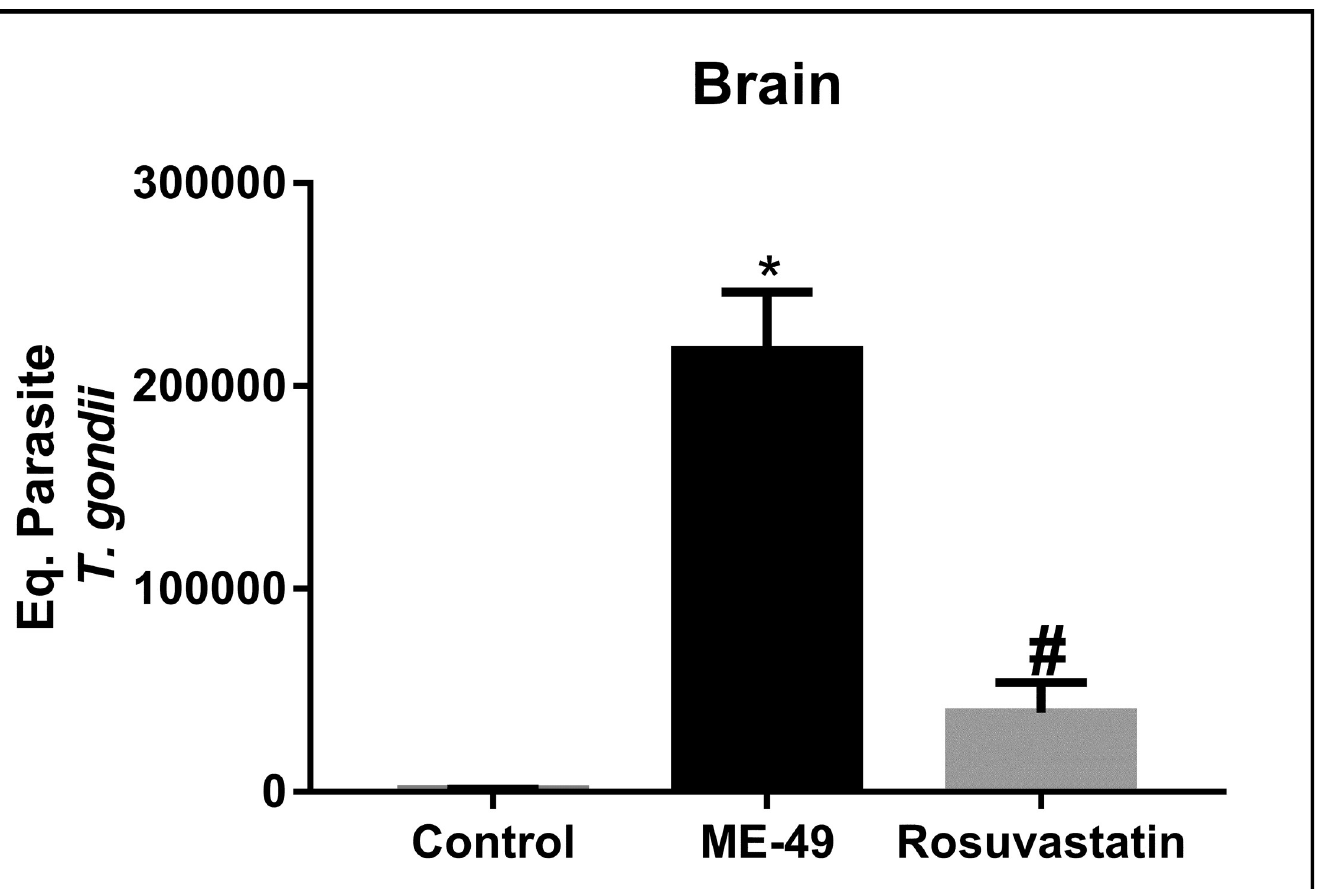
Fig 3. Parasite load in the brain of mice infected with the Toxoplasma gondii ME49 strain (in equivalent parasites). Control: non-infected animals; ME-49: infected animals treated with vehicle; The bars represent the mean ± SEM. � P < 0.05 vs control group, #P < 0.05 vs ME-49 group. One-way ANOVA followed by Bonferroni post-hoc test (n =